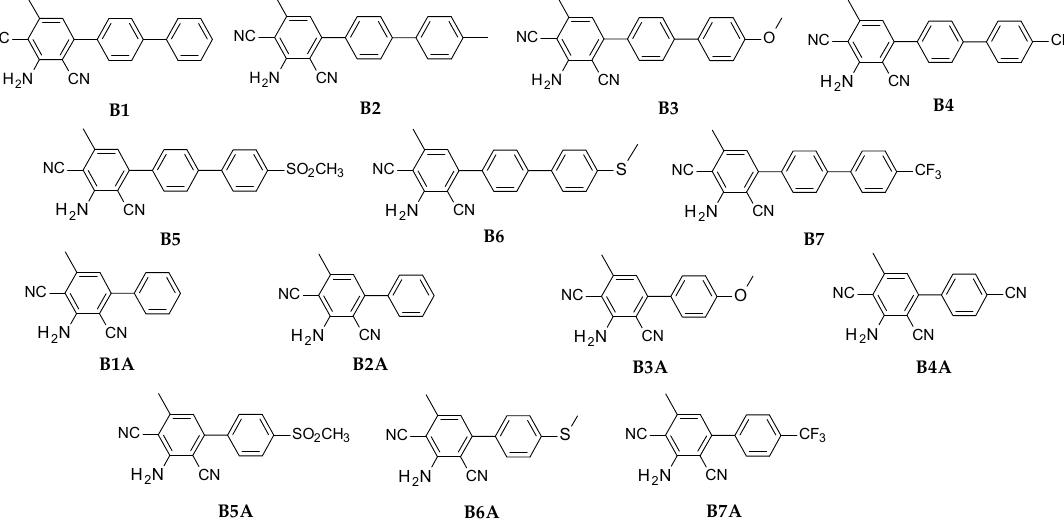
Figure 11. Structure of investigated 2-amino-4-methyl-6-phenyl-benzene-1,3-dicarbonitrile derivatives. Bis-(4- t -butylphenyl)iodonium hexafluorophosphate (Speedcure 938, Lambson Ltd., Wetherby, UK) was used as commercial one-component cationic photoinitiator, and 2,4-diethyl-9H-thioxanthen-9-one (DETHX, from Sigma Aldrich) was applied as a commercial sensitizer, used for comparison. As a part of type II free-radical photoinitiators for the role of e ff ective donor electron ethyl 4-(dimethylamino)benzoate (EDB, from Sigma Aldrich) was used. 3,4-epoxycyclohexylmethyl-3,4-epoxycyclohexane-carboxylate (S105, Lambson Ltd., Wetherby, UK) and trimethylolpropane triacrylate (TMPTA, from Sigma Aldrich) were applied as model monomers for the cationic and free-radical photopolymerization processes, respectively.